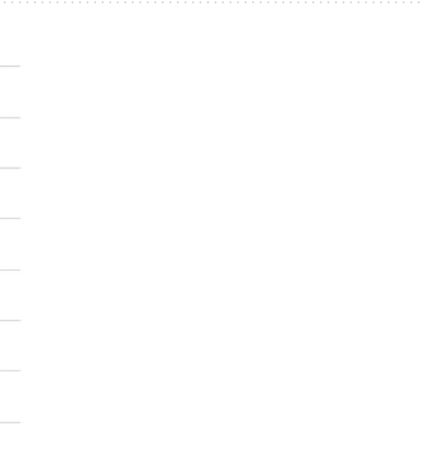
Figure 5. The experts’ and residents’ cost, compared to the standard process